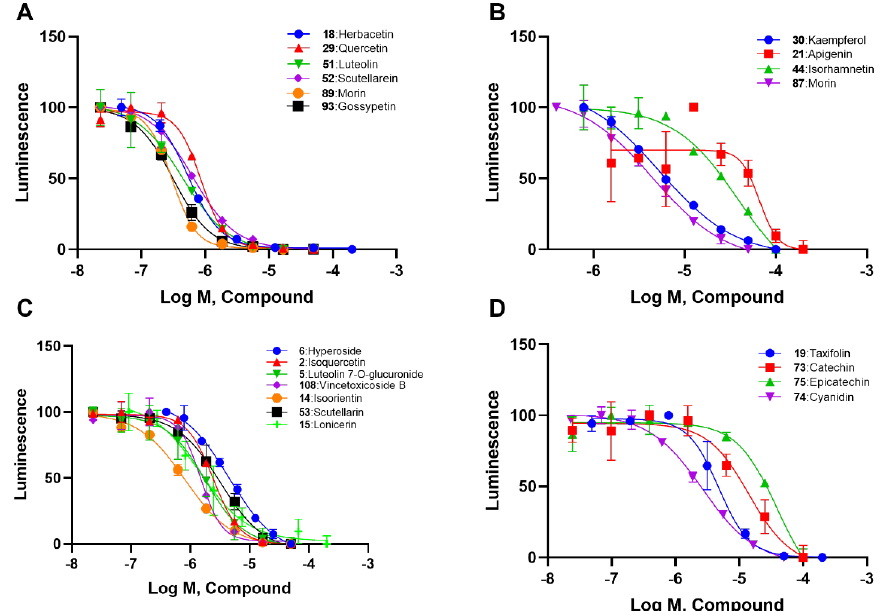
Figure 2. Concentration-response curves of flavonoids in four types: ( A ) ortho–dihydroxyphenyl flavonoids; ( B ) meta–dihydroxyphenyl flavonoids; ( C ) flavonoid glycosides; and ( D ) flavanonols and anthocyanins. Table 1. The SAR of the flavonoid inhibiting properties of ACLY.